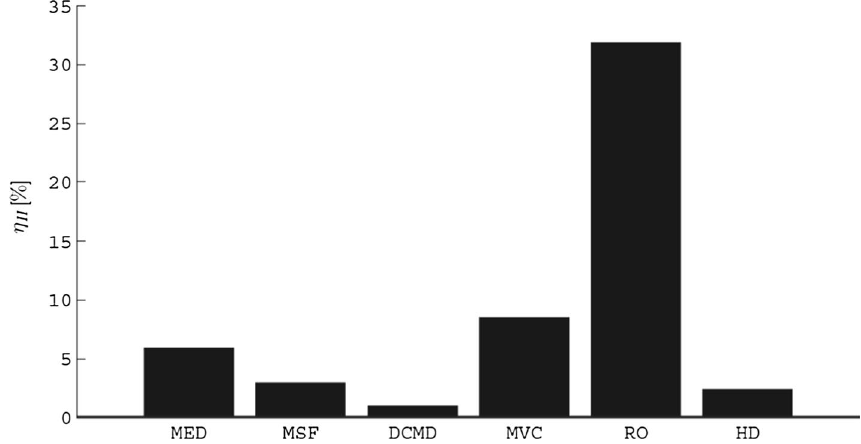
Fig. 40 Comparing the second law efficiency for various desalination processes which RO has a considerably higher value than the other processes (Mistry et al.